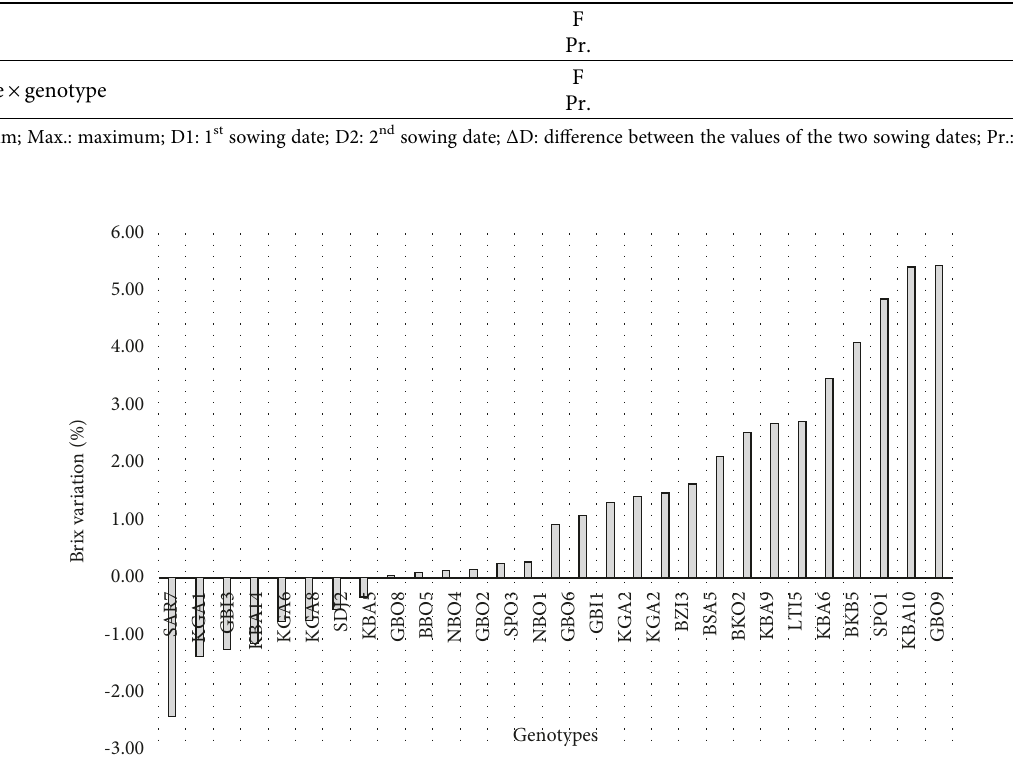
Figure 3: Variation of brix of the stem of the sweet sorghum accessions between the second and the first sowing dates.